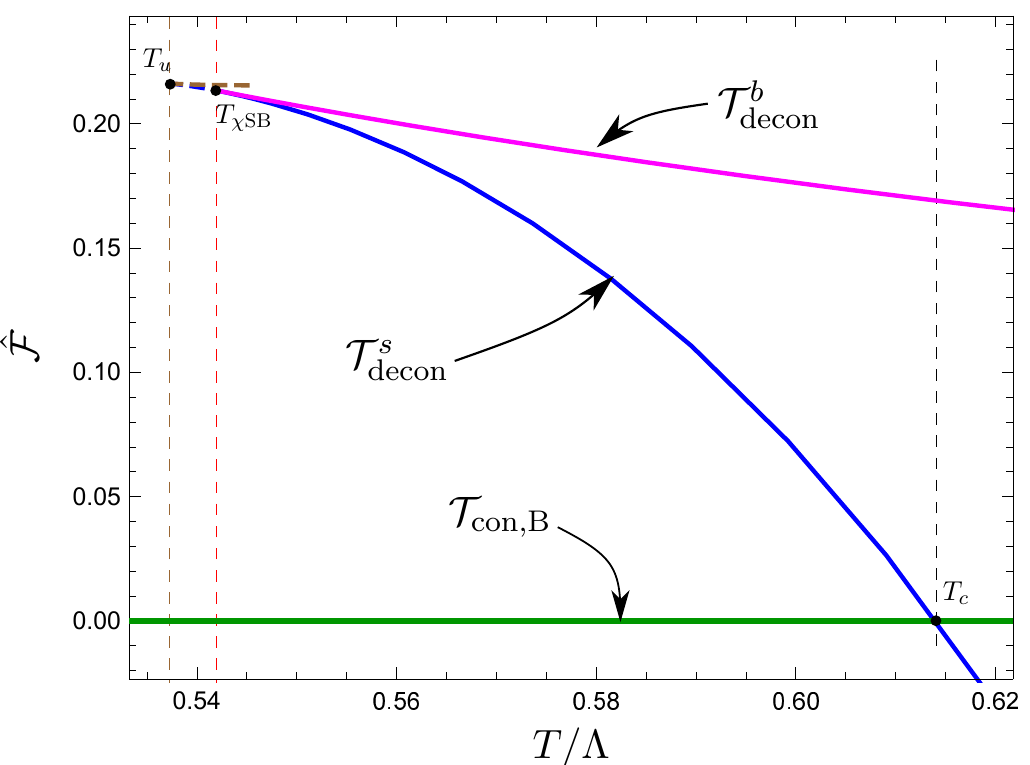
Figure 17 . Phase diagram in the canonical ensemble at µ/ Λ = 0: the reduced free energy density ˆ , see (6.1), versus the reduced temperature T/ Λ for different states in the theory. Vertical dashed F lines indicate critical temperatures T c (black) for the confinement-deconfinement phase transition, T χ SB (red) for the onset of the spontaneous chiral symmetry breaking, and T u (brown) for the s bifurcation point of the states with positive/negative specific heat. decon T